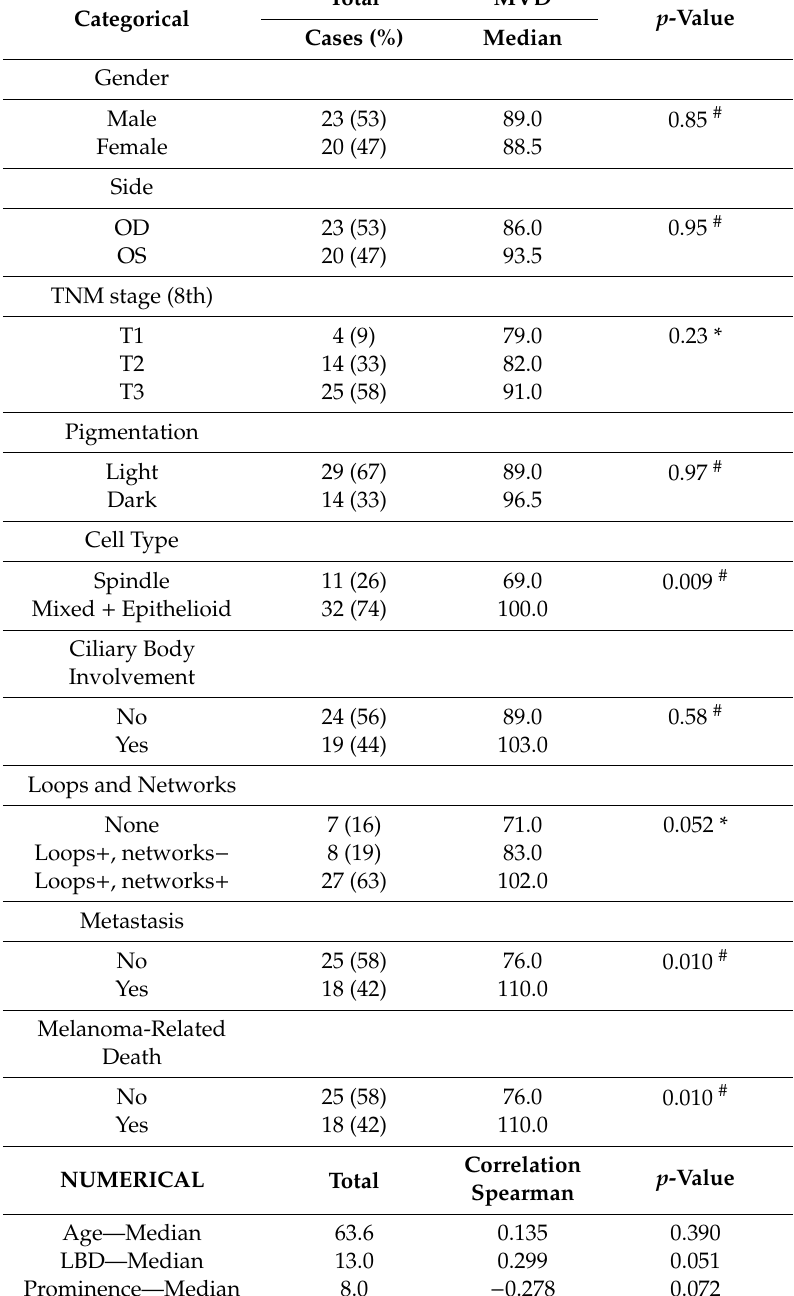
Table 1. Patientandtumourcharacteristicsof43uvealmelanomapatientsforwhomdataonmicro-vascular density (MVD) were